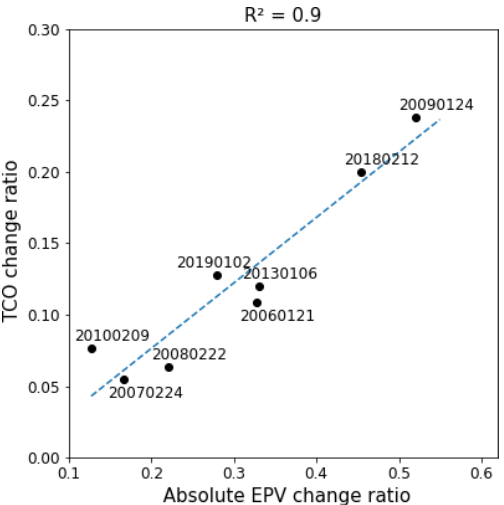
Figure 6. The zonally averaged EPV change ratio at the potential temperature of 850K against the corresponding change in TCO for six studied SSW as well as less persistent major SSWs in 2007 and 2010. The ratio of change for each variable is estimated as the aver- age of 15d after SSWs subtracted by the average of 15d before the SSWs and divided by the average of 15d